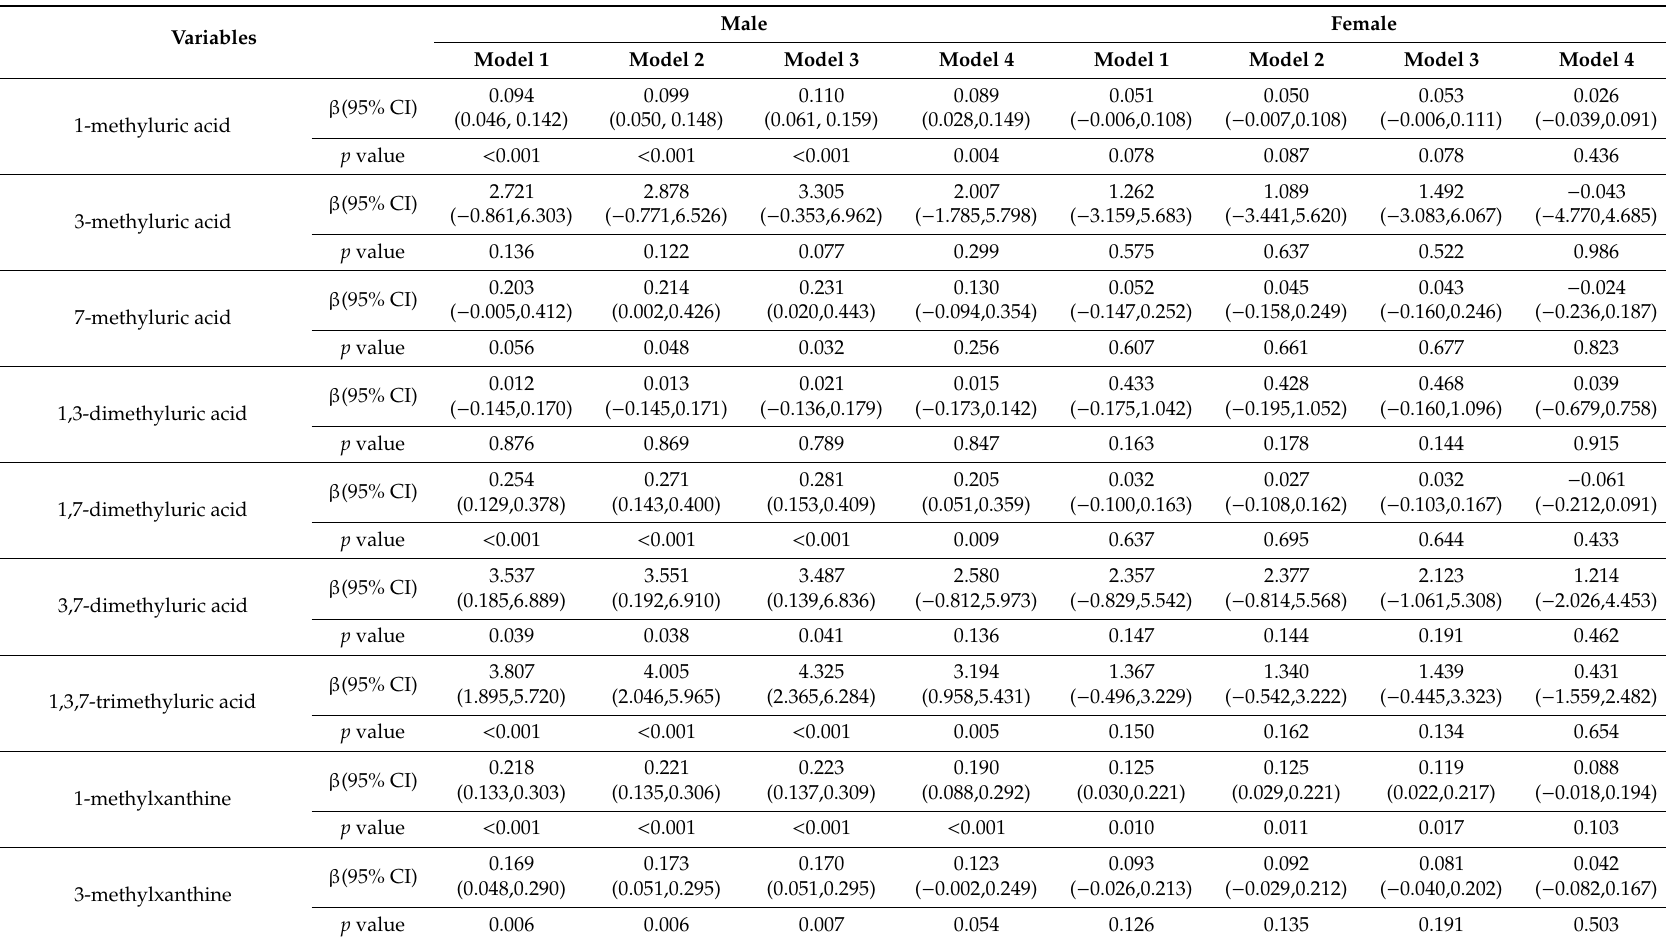
Table 3. Association between urinary ca ff eine metabolites and urine flow rate as categorized by